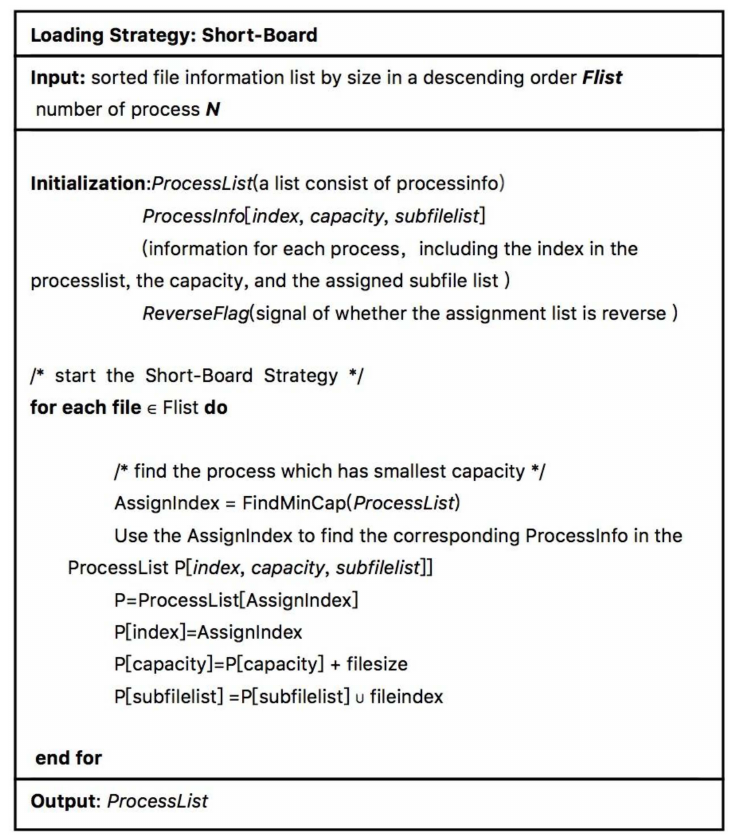
Figure 10. The pseudo code of Short-Board.